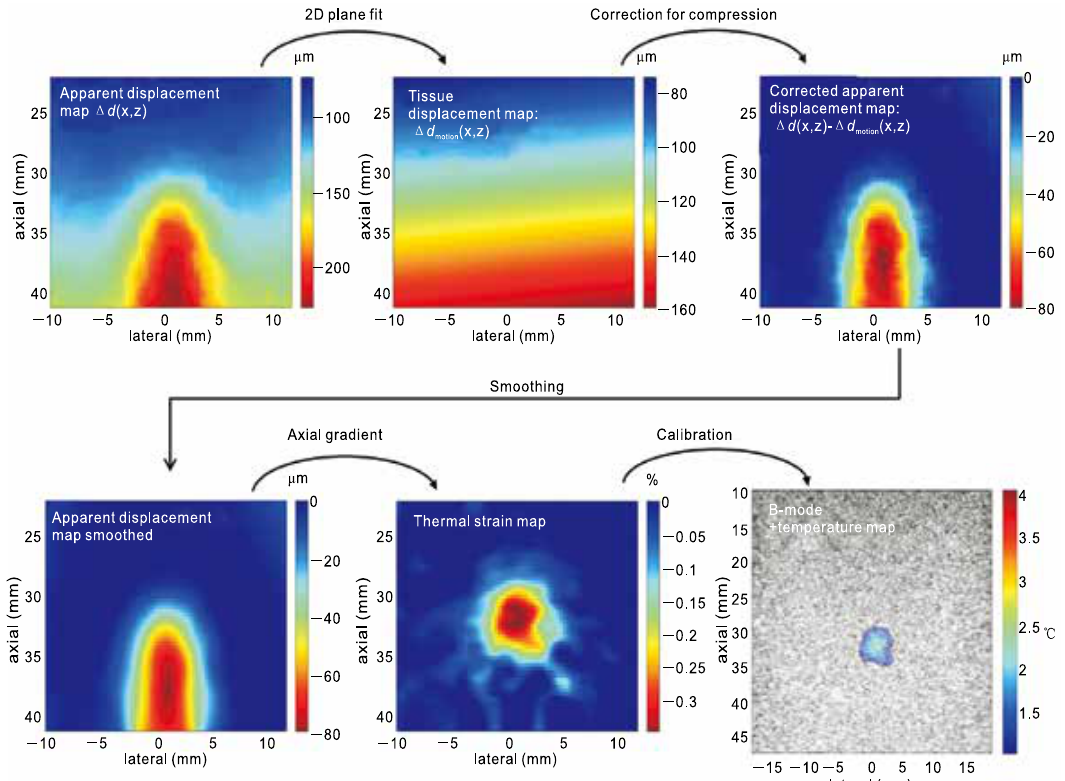
Figure 1 Processing steps of transforming the apparent displacement map to the final temperature map